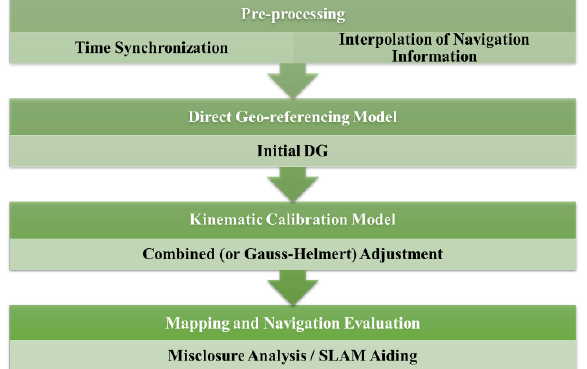
Figure 1. The flow chart of data processing and applications